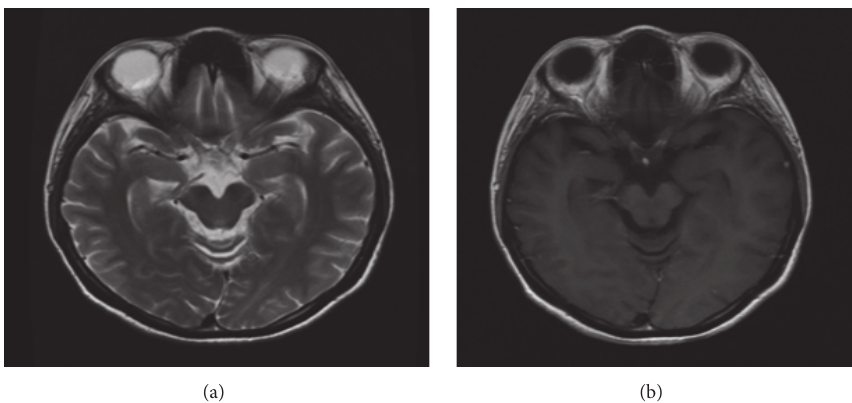
Figure 3: (a) T2 weighted image showing bilaterally oedematous optic nerves and optic chiasma with (b) patchy enhancement of the optic chiasma on T1 weighted image. This patient was negative for both anti-AQP4 antibody and CSF OCB.